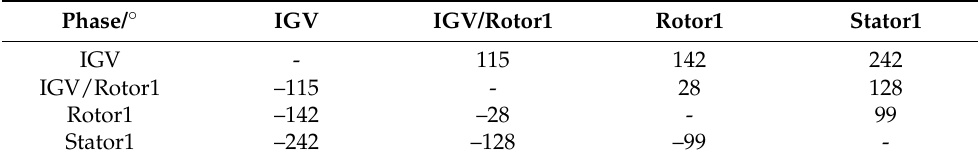
Table 2. Phase difference of characteristic frequency of noise signal at different measurement